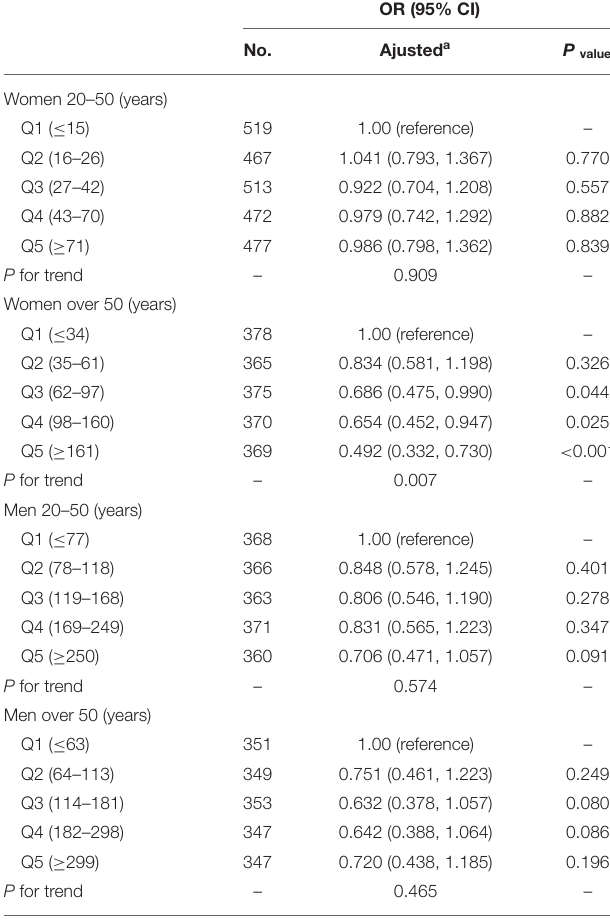
TABLE 5 | Effect of serum ferritin on headache in different sex and age